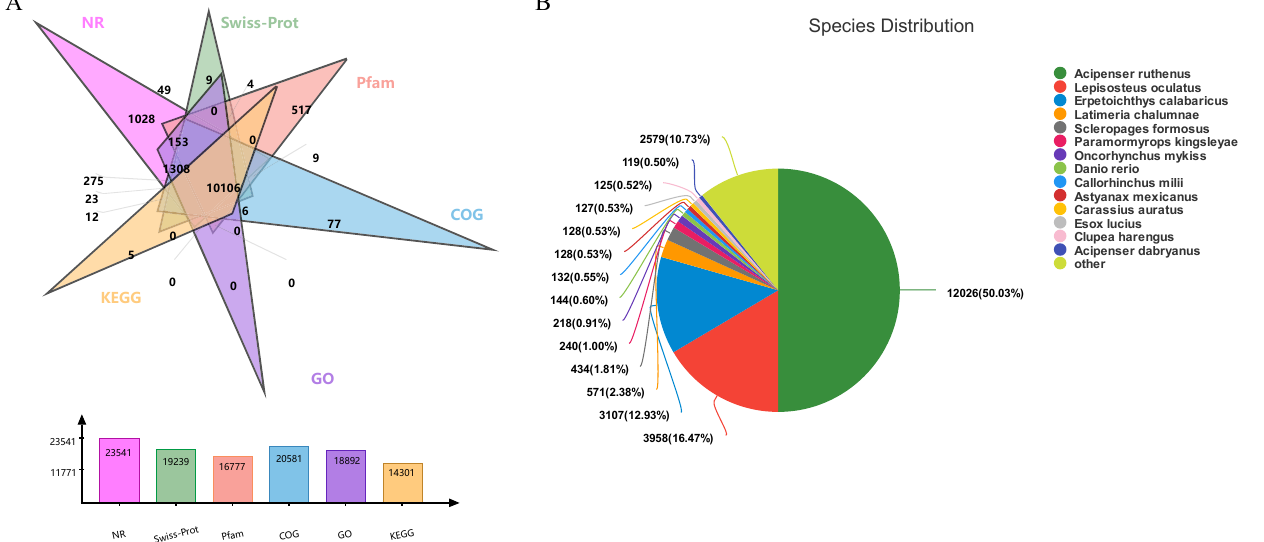
Figure 3. Distribution of the annotated genes: ( A ) unigene-function-annotated Venn diagram; ( B ) NR-annotated pie chart of species distribution.